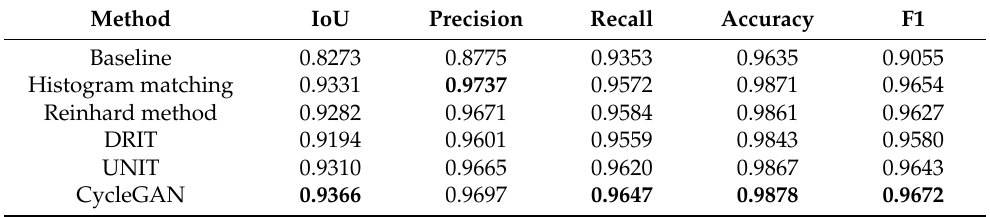
Table 1. Evaluation metrics of the semantic segmentation results obtained based on different image color translation methods for the Wuhan University building change detection dataset.